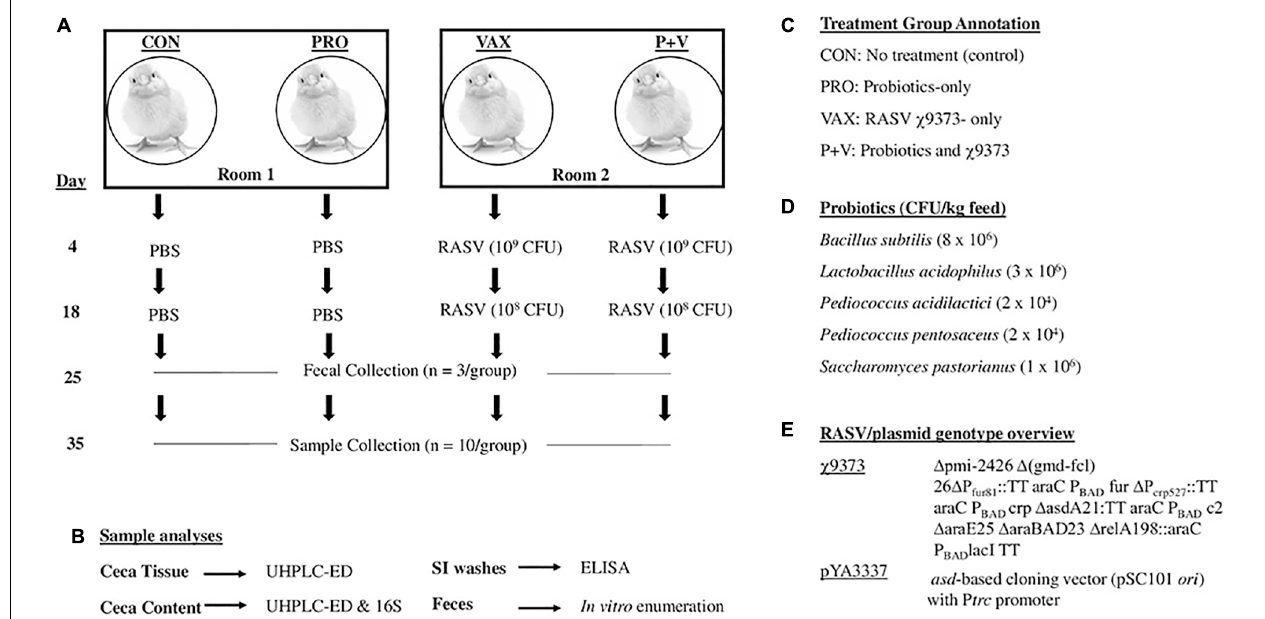
FIGURE 1 | Overview of present study. Four groups of birds were evenly split into two rooms, one group given probiotics per room. At 4 and 18 days, birds received recombinant attenuated Salmonella vaccine χ 9373 (RASV) or PBS as a control. Samples were collected at days 25 and 35 (A) , which were then used for subsequent analyses (B) . Summary of abbreviations used in this study for treatment groups (C) . Probiotic CFUs in mix (D) . Genotypic details of the RASV (E)